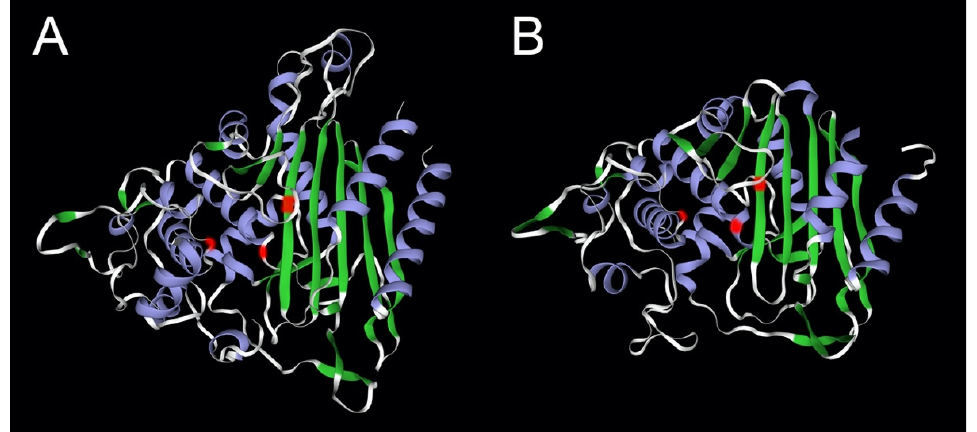
Figure 2. Comparison of the beta-lactamase fold of LACTB with that of the bacterial PBP- β Ls protein flp. Panel ( A ): LACTB (P83111); panel ( B ): flp protein of Staphylococcus aureus (Q7A5Q5). The locations of the catalytic site residues in the signature motifs [3] are marked in red, - S ISK-, - Y ST-, and - H TG- for LACTB, and - S NTK-, - Y SN-, and - H SG- for the fpl protein. The structure of LACTB was determined by cryo-electron microscopy [2] and that of flp by X-ray crystallography [42]. The image was generated partially using SWISS-MODEL [43].